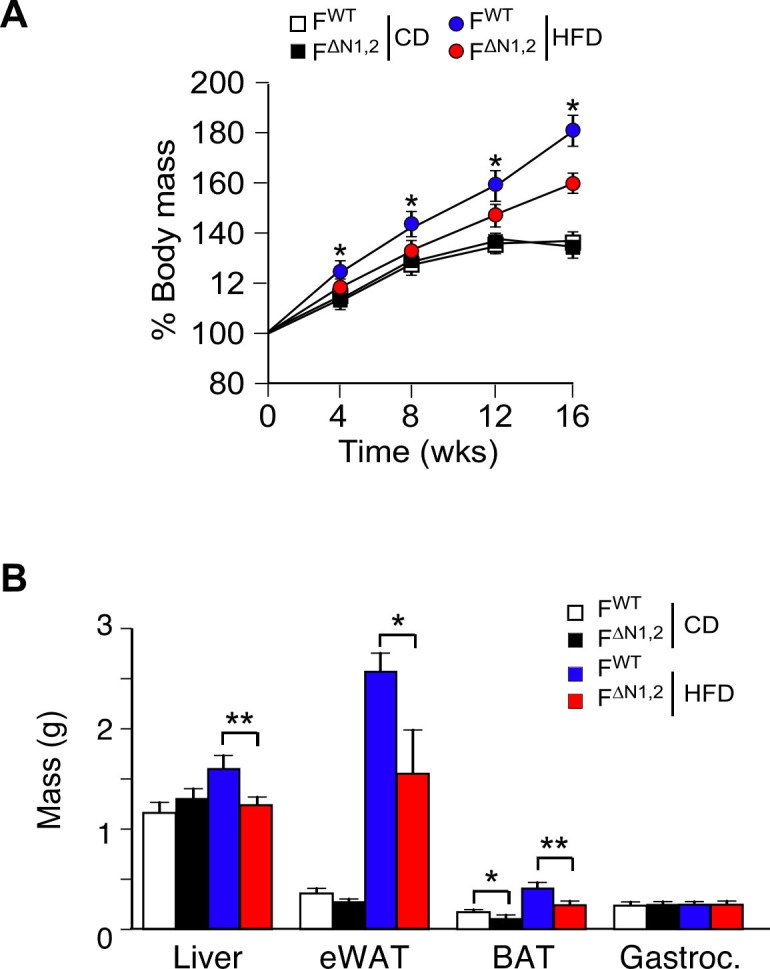
Effect of adipose tissue-specific NOVA1/2-deficiency on organ mass.(A) The change in% body mass of FWT and F∆N1,2 mice fed a CD or ais presented (mean ± SEM; n=8~30; *p<0.05). (B) The mass of the liver, epididymal white adipose tissue (eWAT), interscapular brown adipose tissue (BAT), and gastrocnemius muscle (Gastroc.) of FWT and F∆N1,2 mice fed a CD or a(16 wk) is presented (mean ± SEM; n=21). Statistically significant differences between FWT and F∆N1,2 mice are indicated: *p<0.05; **p<0.01.